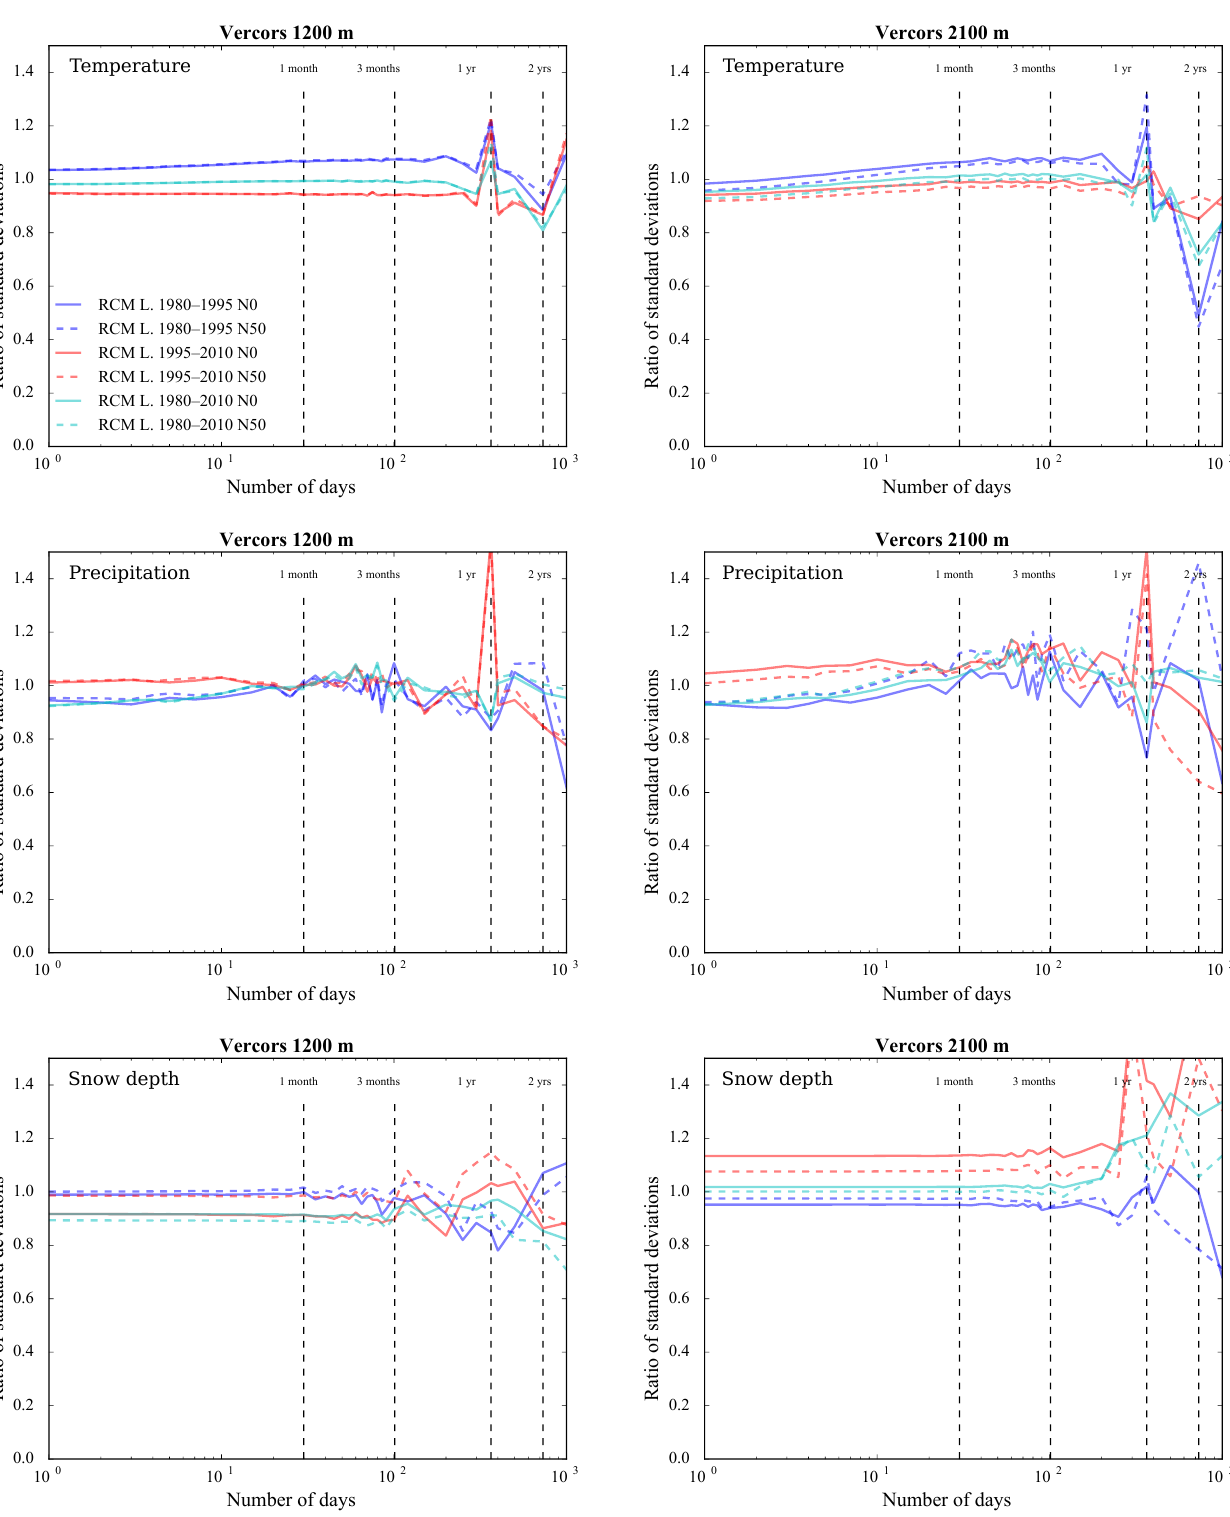
Figure 8. Ratio of standard deviation values between the SAFRAN reanalysis and adjusted RCM temperature, precipitation and snow depth (using Crocus in this case) as a function of the integration window over the evaluation period for the Vercors massif at 1200 and 2100ma . s . l